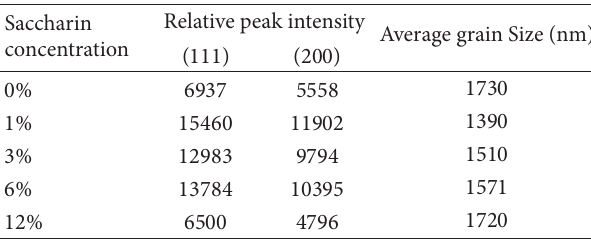
Table 1: Peak intensities and average grain size values of CdO films as a function of saccharin